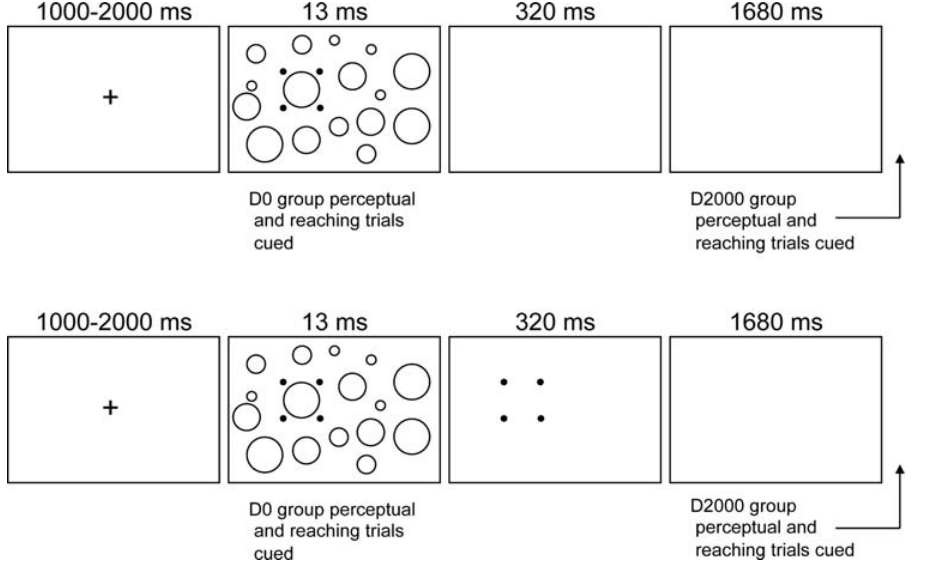
Figure 1. Schematic of the sequence of visual and auditory events associated with the performance of no-mask (top panels) and mask (bottom panels) trials for D0 and D2000 groups. Actual trials presented the four-dot mask as solid red circles; in this schematic the four- dot mask is simply represented by the filled circles (see panel two). For the D2000 group, perceptual and reaching responses were cued following offset of the fourth panel in the timeline (i.e., 2000 ms after onset of panel two). Note that due to scaling limitations only four circles of each target size are shown in the stimulus array.